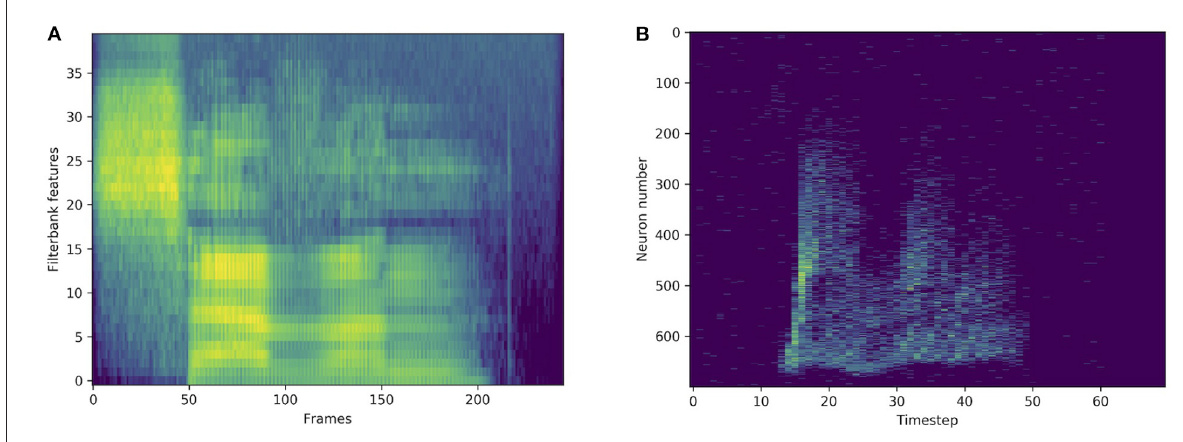
FIGURE3 Standard representation via filterbank features (A) and spike train representation via LAUSCHER (B) of the same spoken digit (seven in English) from the SHD dataset.